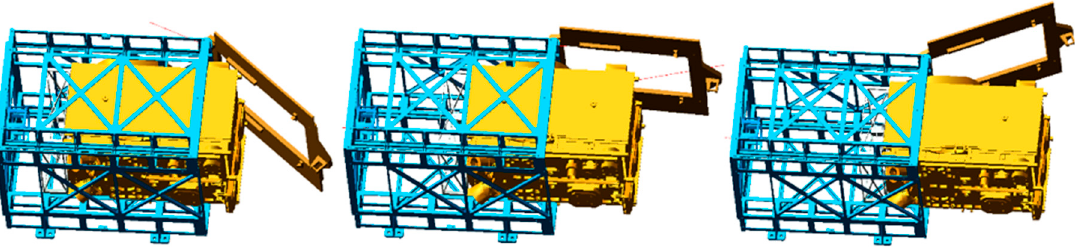
Figure 12. Separation process.